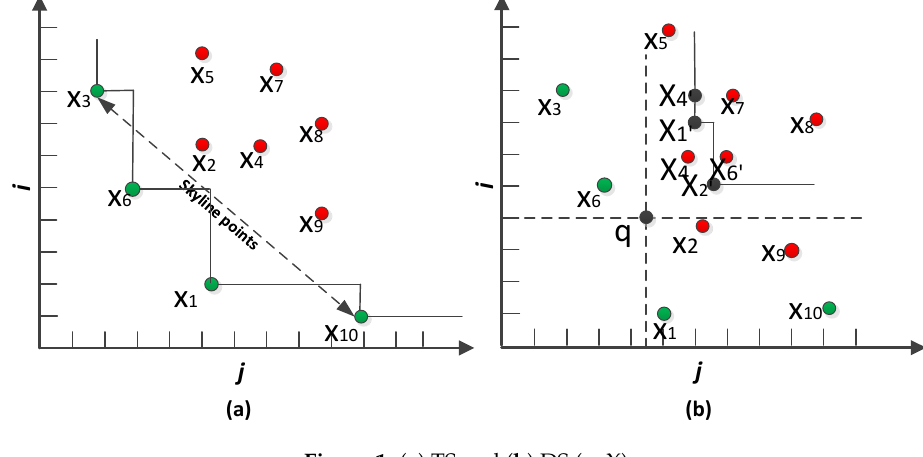
. In Figure 1b, points x 1 , x 2 and x 4 are the dynamic skyline points of q . Each point x i = ( x i [ j ], x i [ i ]) is transformed to x i ′ = ( x i [ j ]- q [ j ], x i [ i ]- q [ i ]).